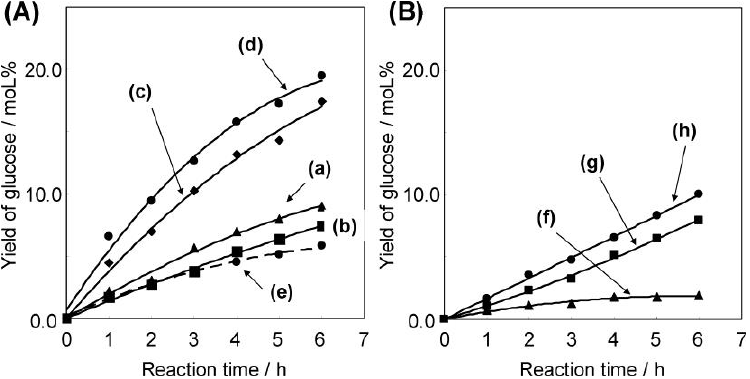
Figure 14. Time courses for d-glucose formation by the hydrolysis of cellobiose over ( A ) bulk and supermicroporous/mesoporous Nb 2 O 5 · n H 2 O and ( B ) strongly acidic resin. ( a ) Mesoporous Nb 2 O 5 · n H 2 O prepared with L64, ( b ) supermicroporous Nb 2 O 5 · n H 2 O prepared with P85, ( c )